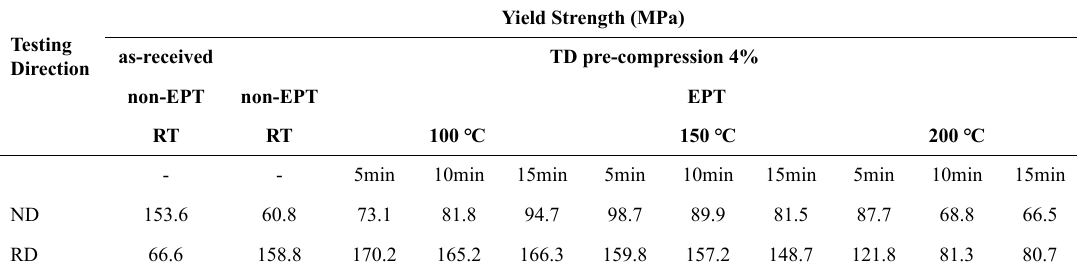
Table 4. Yield strength of the ND and RD specimens at various conditions